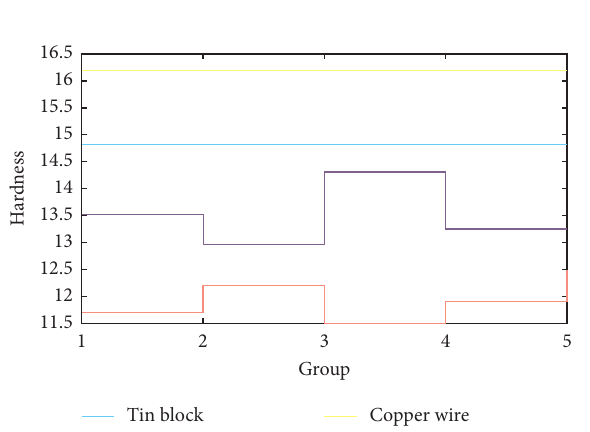
Figure 3: Pattern stress-strain curve.